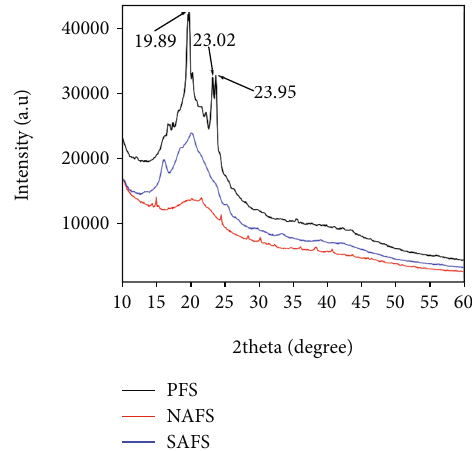
Figure 4: XRD spectra of pure (PFS) and treated (NAFS and SAFS) fennel seed